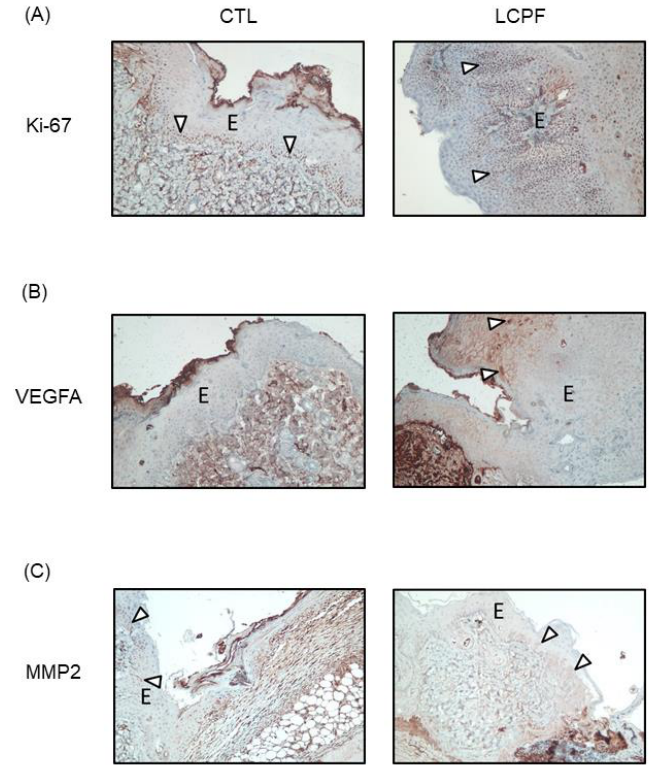
Figure 9. Immunohistochemical analysis of Ki-67, VEGFA, and MMP2 in a full-thickness wound treated with LCPF. Representative images of wounded skin at day 4 post-operation stained with ( A ) Ki-67, ( B ) VEGFA, and ( C ) MMP2. The right panel demonstrates a dorsal wound treated with LCPF wet dressing. The left panel shows a dorsal wound treated with 0.9% saline as the control (positive staining cells; E, epidermis).